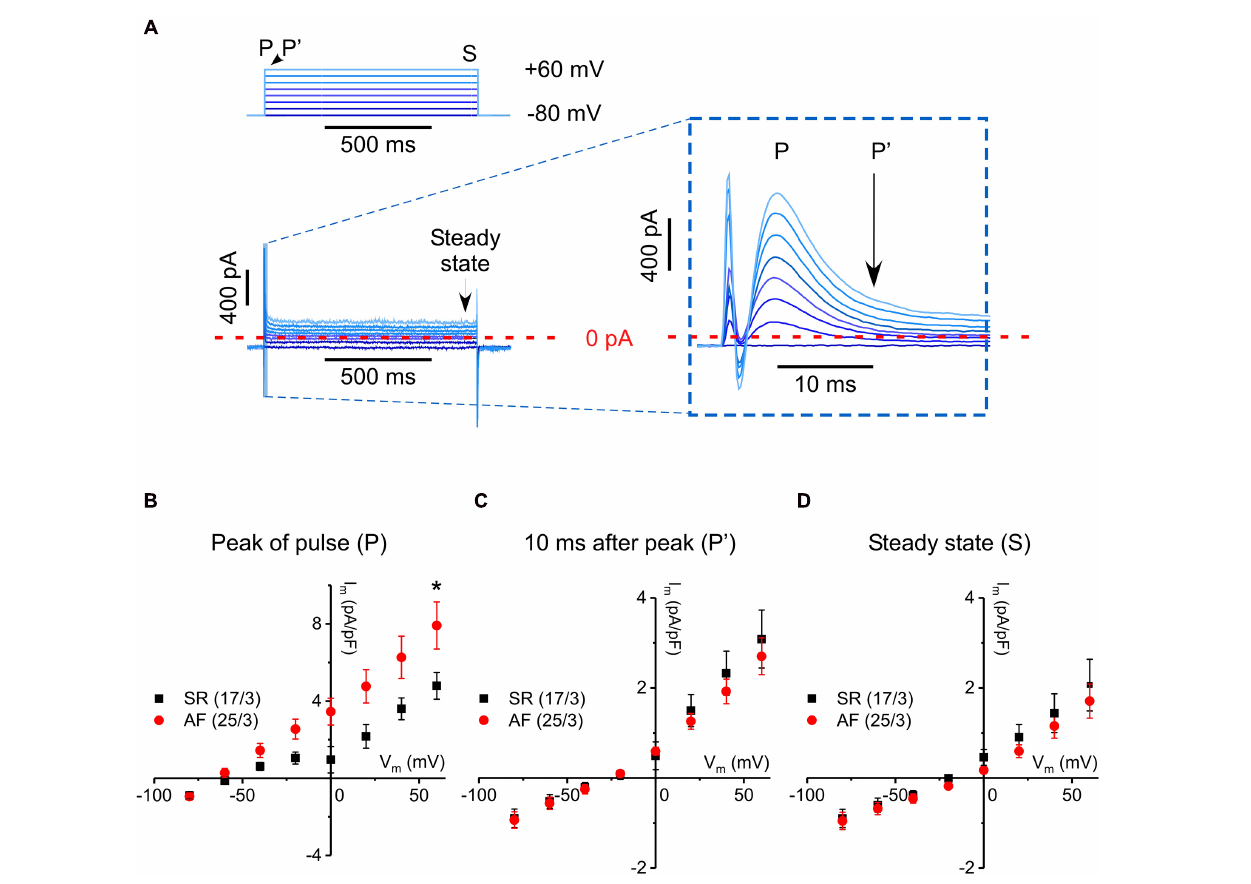
FIGURE 3 | Fast transient outward current measured with a step-pulse protocol in cells from tissue donors with SR and AF. (A) Pulse protocol and a representative current recording. Inset: Enlargement of early (first 10–15 ms) current dynamics, as indicated in A (stimulation artifact truncated in the enlarged image). Depolarizing steps activate a linearly increasing, transient current of < 10 ms in duration. (B–D) IV curves constructed from peak current values (P), from values 10 ms after P (P (cid:48) ), and from values at the end of each voltage step (S, steady state), respectively, for fibroblasts from SR and AF donors. Please note different scales of Y-axes. *Indicates significant